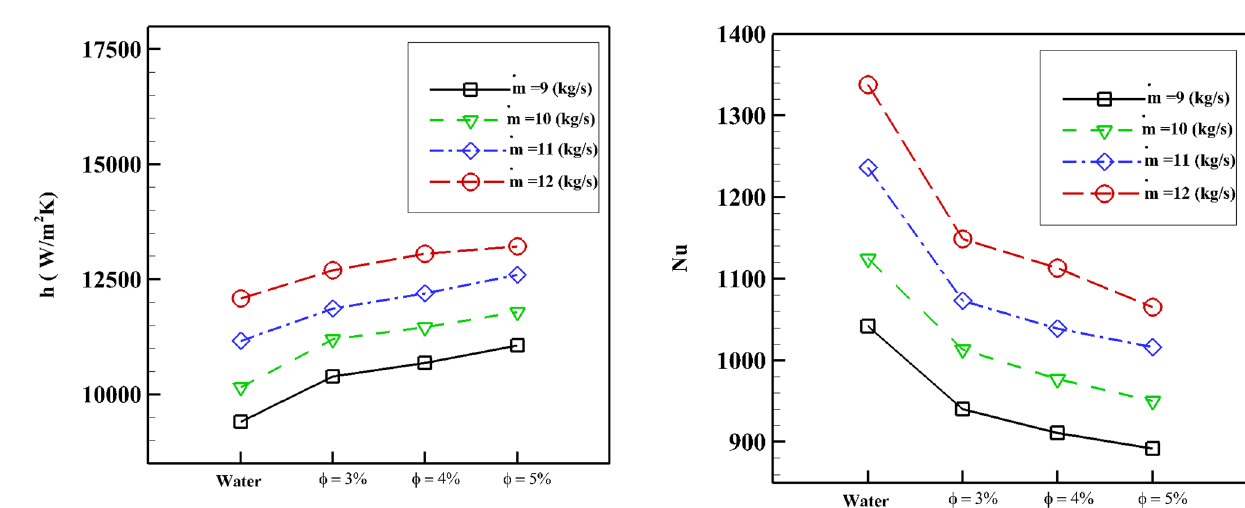
Fig. 21 Nusselt number at constant flow rate vs